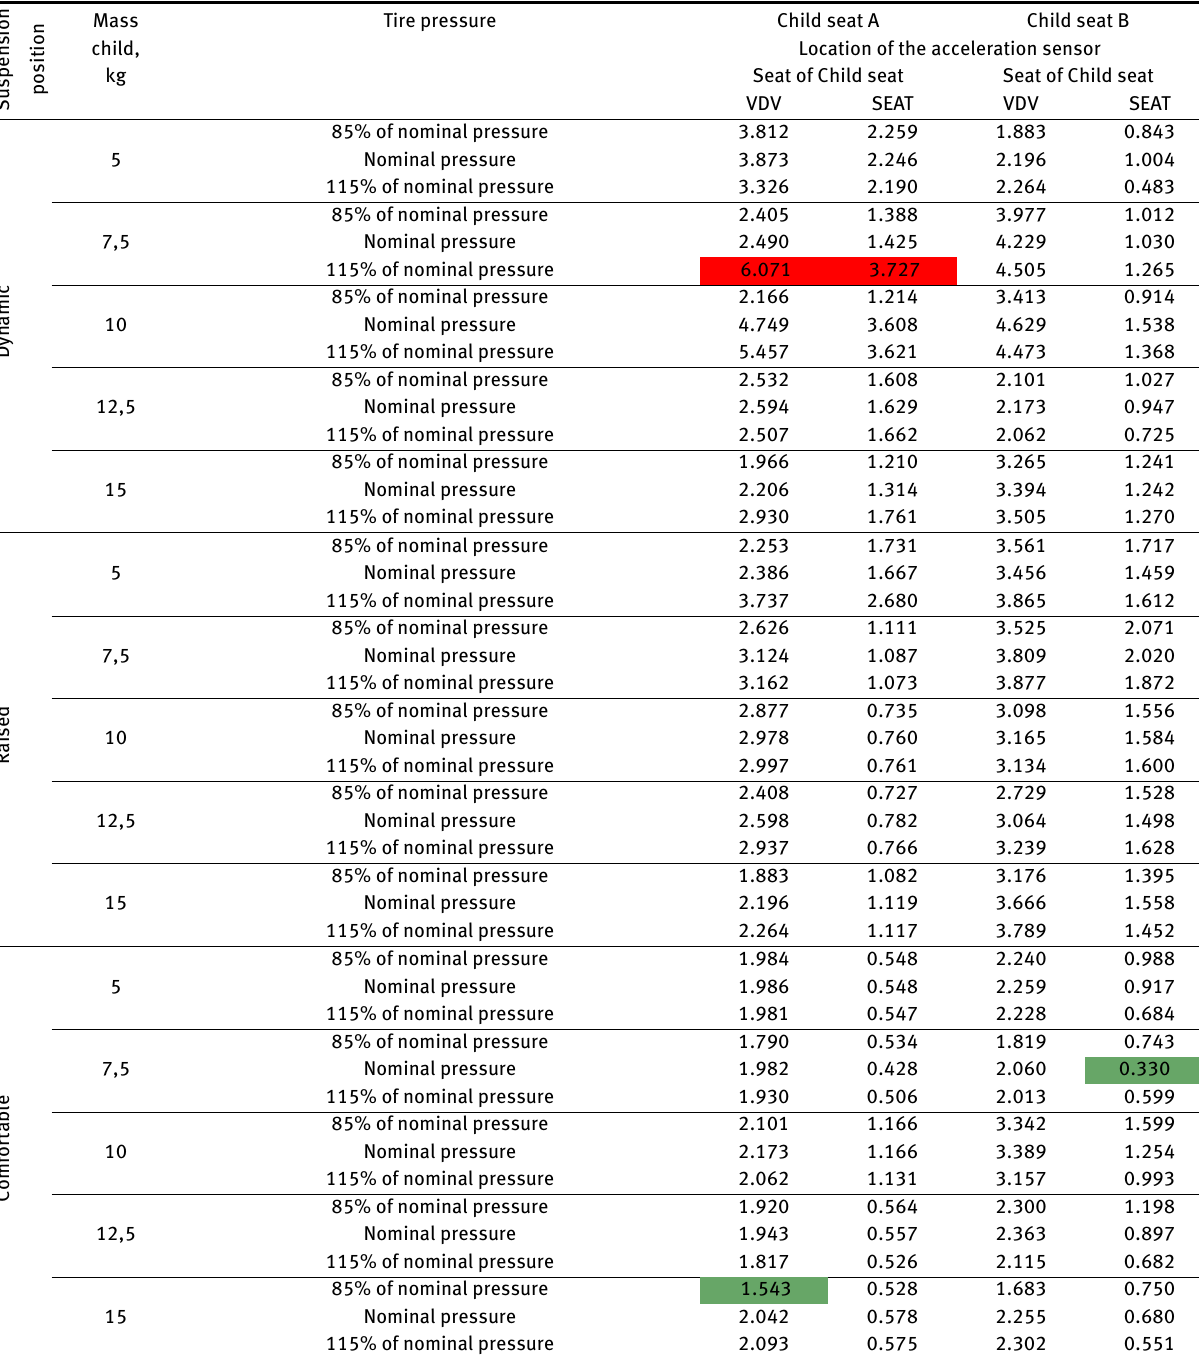
Table 3: Results of the VDV and SEAT